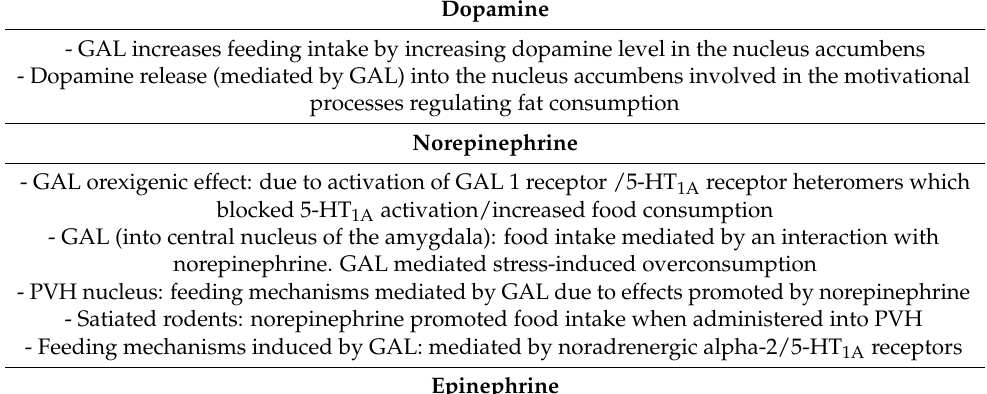
Table 4. GAL and other substances: relationships [2,26,38,55,91–99].